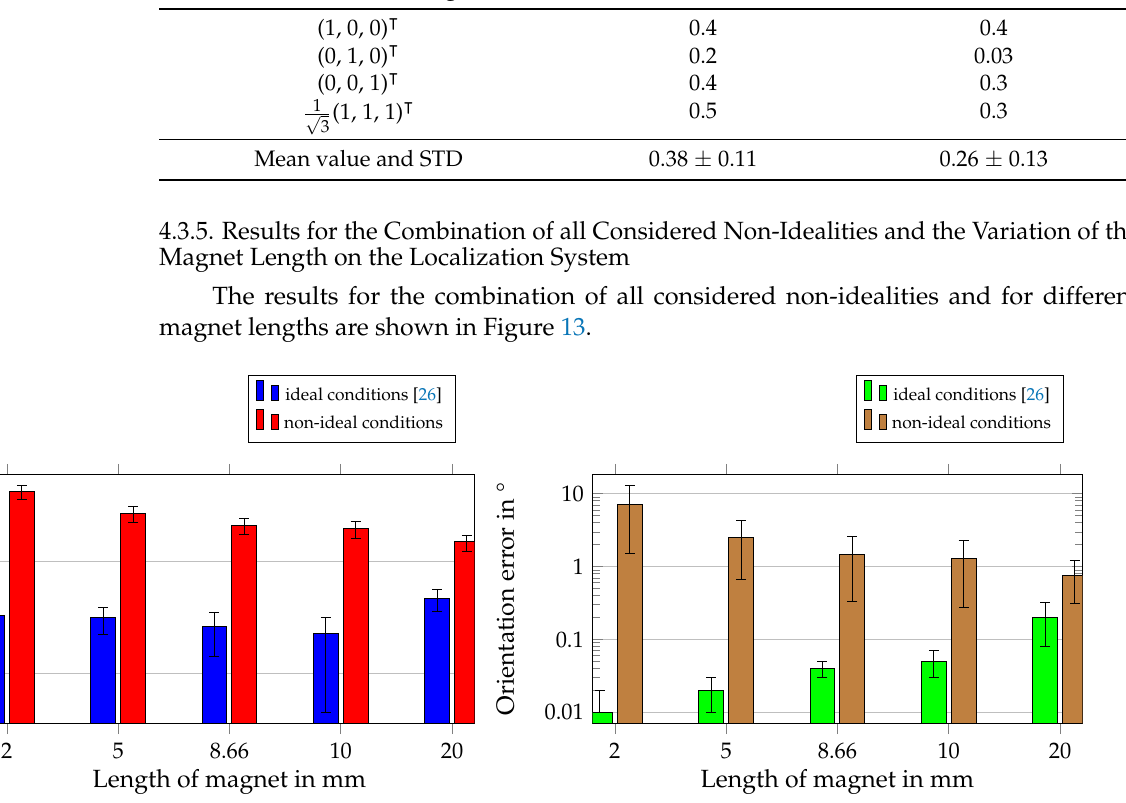
Figure 13. Comparison of localization performance under non-ideal conditions with performance under ideal conditions [26] for different applied magnet